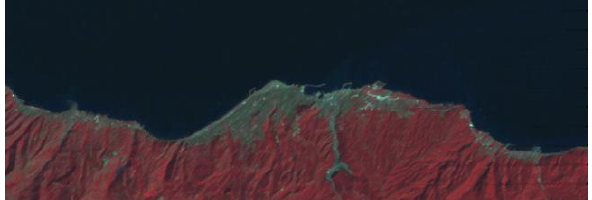
Figure 1. The study area covering Trabzon